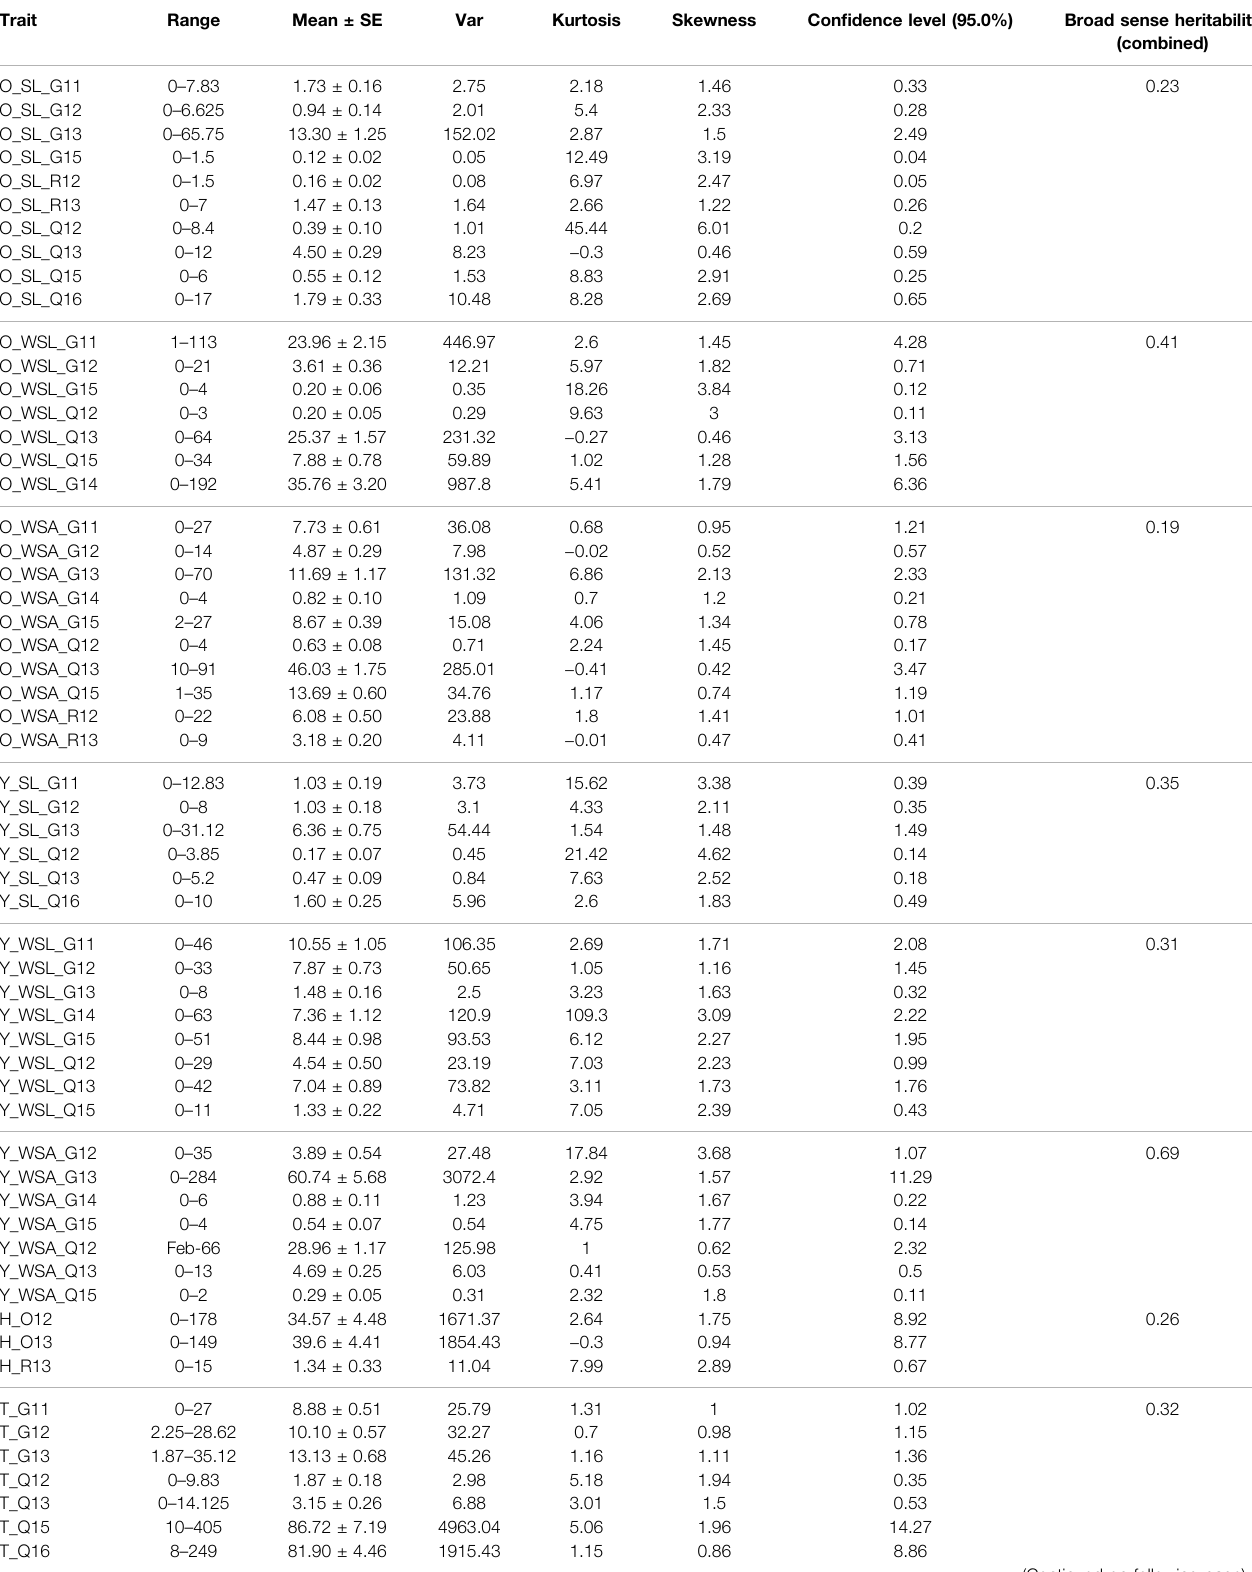
TABLE 2 | Descriptive statistics of various traits of investigated insects in winter wheat (WW) panel. For details, see materials and methods.